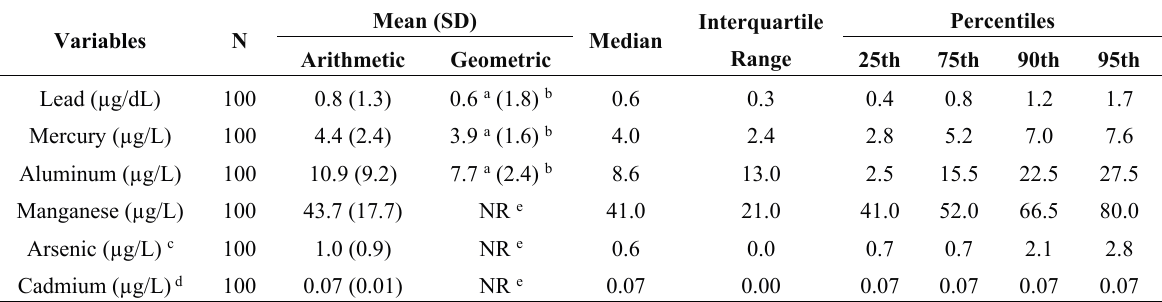
Table 2. Distribution of lead, mercury, arsenic, cadmium, manganese, and aluminum concentrations in umbilical cord blood in a sample of n = 100 newborns from Jamaica.